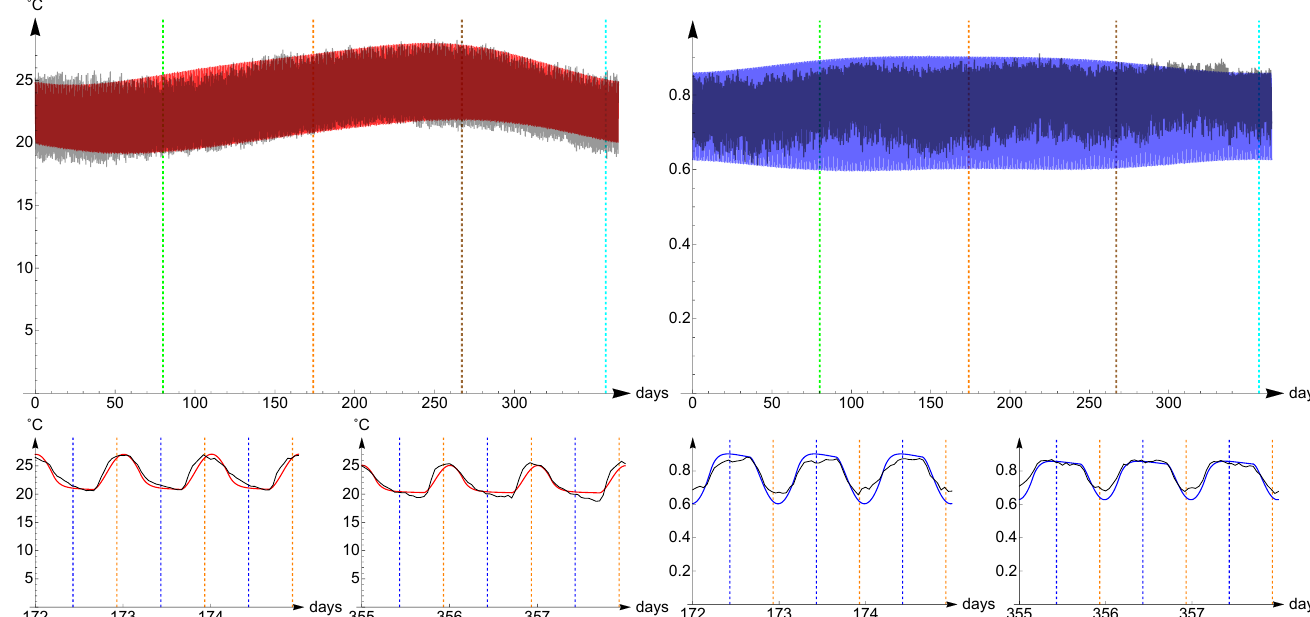
Figure 4. The left plots displays average real temperature ¯ T (in gray) and numerically computed temperature (in red). The top plot ranges over a year, the bottom plots display the behaviour over three days in two different periods of the year, from day 172 (summer sostice) to day 175 and from day 355 (winter solstice) to 358. The right plots display average real relative humidity ¯ H (in gray) and numerically computed humidity (in blue). The region taken into consideration is Hilo. The grid lines represent solstices, equinoxes ( top plots), noons and midnights ( bottom